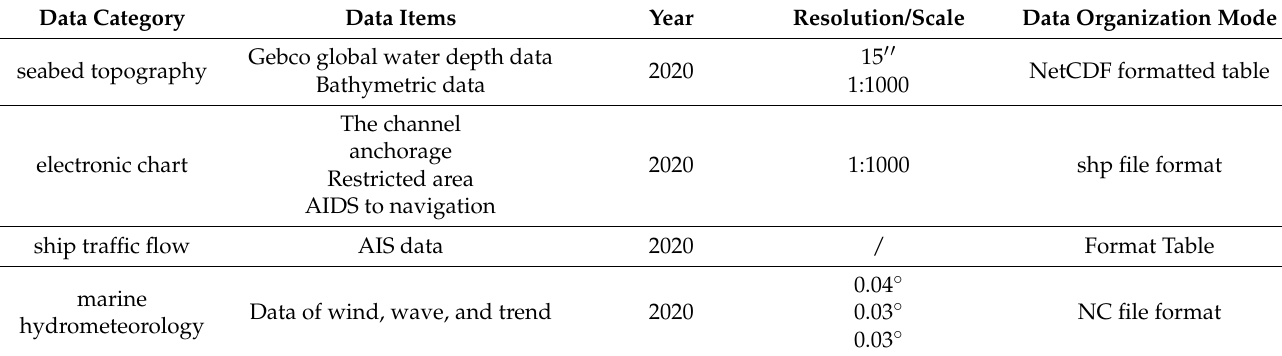
Table 1. Classification of data